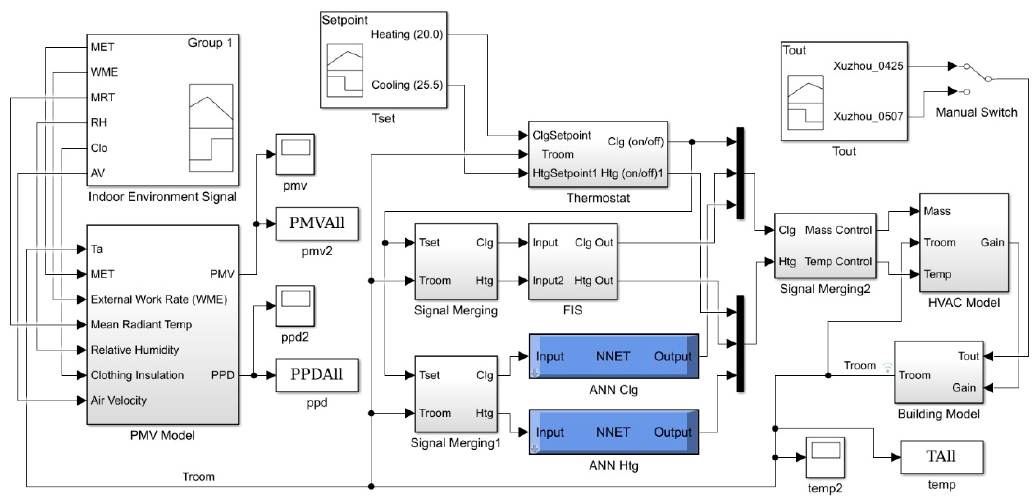
Figure 5. Block diagram.